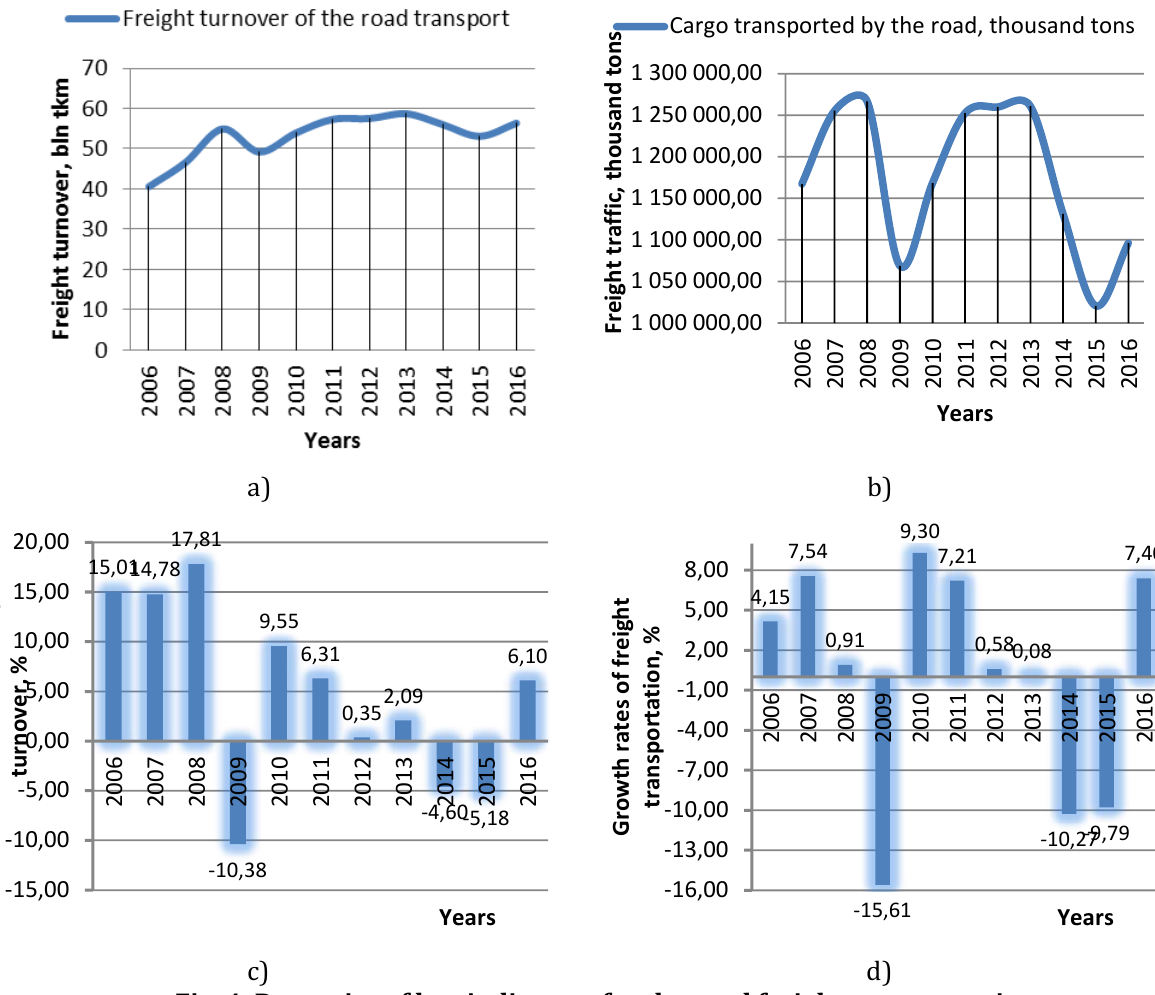
Fig. 4. Dynamics of key indicators for the road freight